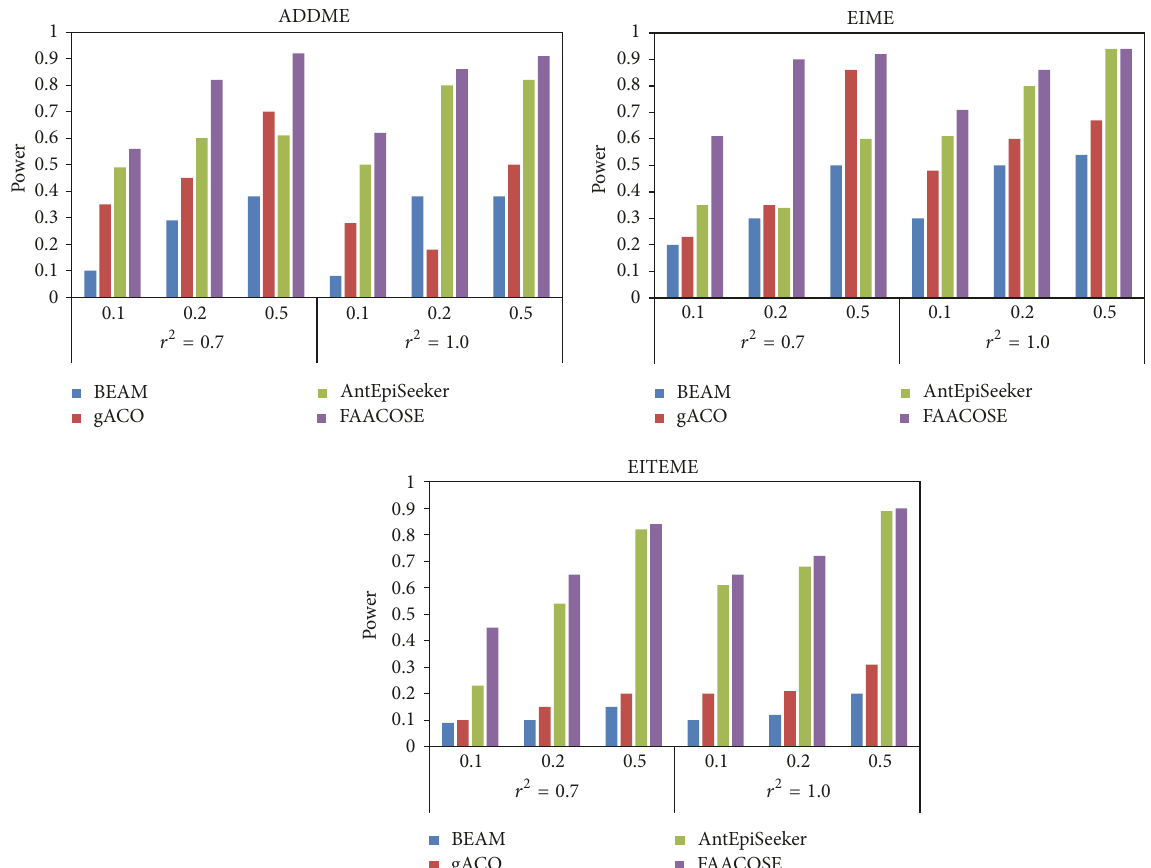
Figure 3: Power comparisons between existing methods and FAACOSE on three